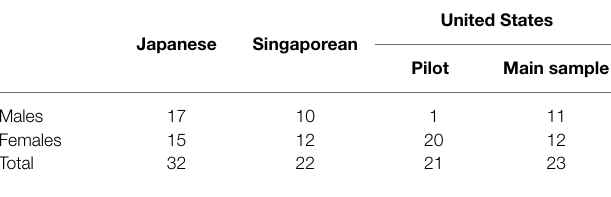
TABLE 1 | Eligible subjects for the